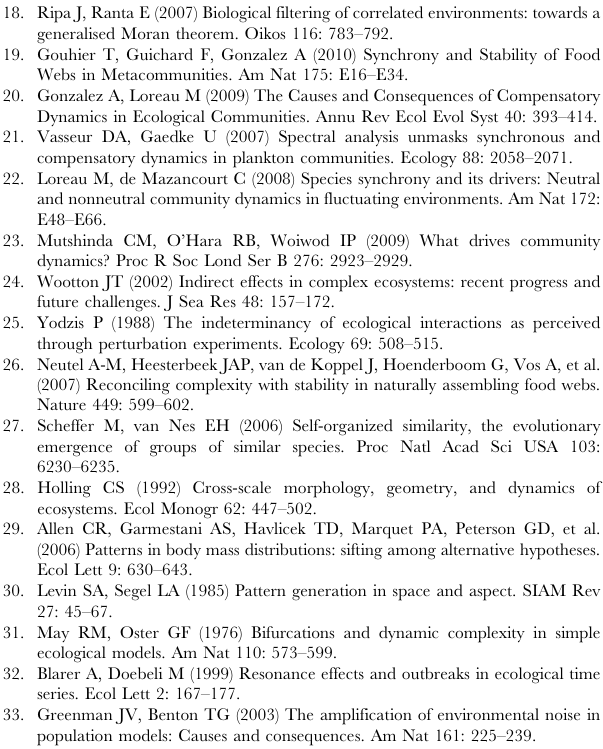
the species allowed to fluctuate were randomly selected and the correlations between every pair of species within each simulation calculated. Grey points are individual results, black line is a spline fit to the mean value for each phenotype difference. (B) As panel A, but with only 5 species fixed. We see that as we increase the number of species that fluctuate, the correlation shifts from a mostly flat, purely compensatory pattern to the oscillatory pattern characteristic of the full model (compare with the full model and pairwise interaction curves in Figure 4A). System and runtime parameters as in Figure 4A; fluctuating species started at random abundances. Figure S9 Comparison of linear analytical results and simula- tions. The amplitude of the various deformations for systems with 6, 10, and 15 species – curves show the exact result for the linearized model (red), and for the full model simulated at low ( s a / , a . = 0.045, blue) and higher noise ( s a / , a . = 0.15, black). As in Figure 4B in the main text, the perturbations are ordered by their by their roughness. The finite simulation time (10 5 cycles in all cases) implies that the slowest deformation cannot be fully captured in simulations (all perturbations to the right of the vertical, dotted line have relaxation times longer than the simulated time-span). With only 6 species, the longest relaxation time is only , 3,000 cycles. Hence, the 10 5 -step simulation captures the full behavior of all deformations and shows excellent agreement with the linear approximation. With 10 species, the longest time-scale is above 10 5 cycles and greater deviations are seen at the slowly-relaxing deformations. This effect is even more marked for 15 species, but the agreement is still good for the smoother deformations. Specifically, the crucial feature – ampli- tude peaking at medium-smooth deformations – remains. The 15- species system is identical to that used in all figures in the main